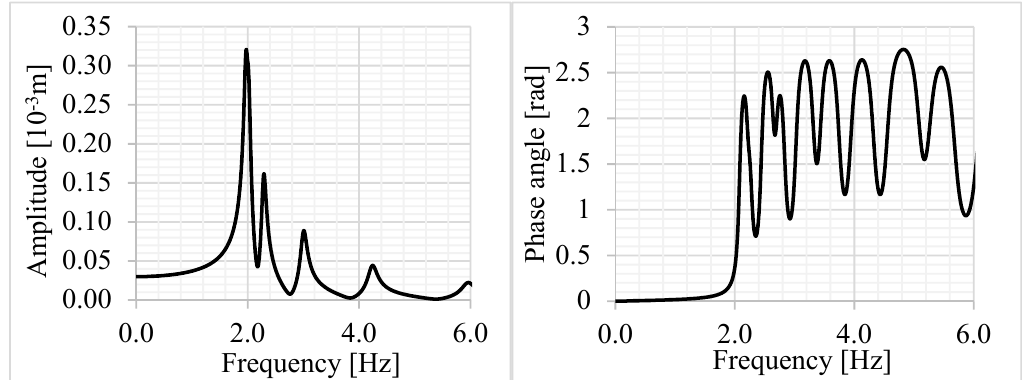
Figure 14. Dynamic response of the analyzed slab for a concentrated force excitation.